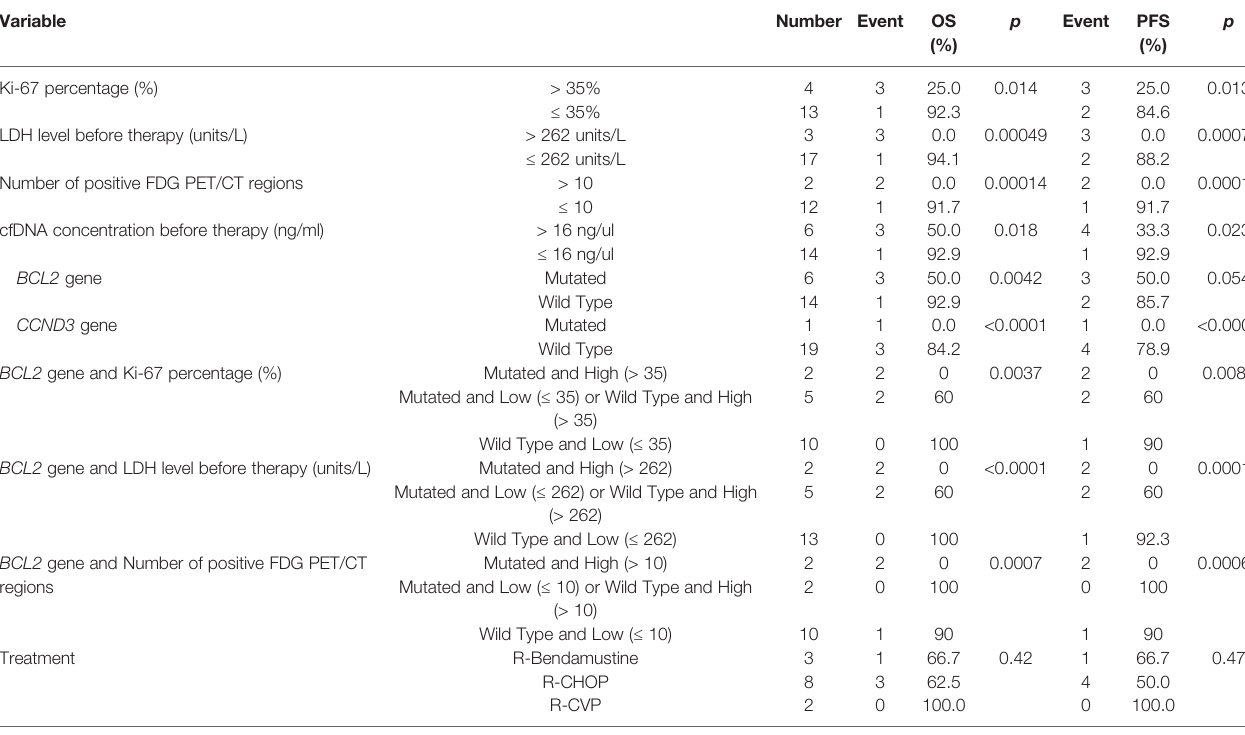
OS, Overall Survival; PFS, Progression-Free Survival.